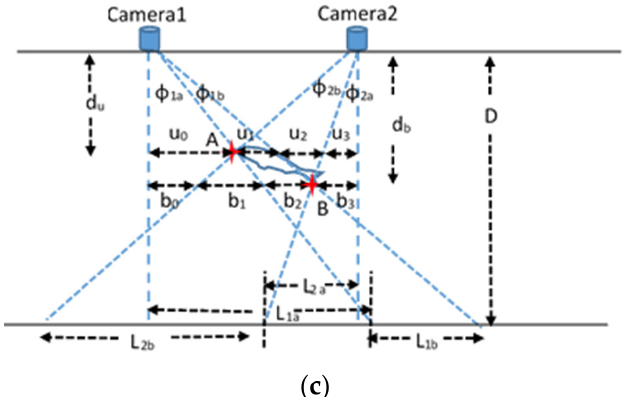
Figure 16. Measuring the fish length from a known distance with a single camera ( a ), a fish that is not rotated and at an unknown distance with stereo vision ( b ) and a rotated fish at an unknown distance with stereo vision ( c ).